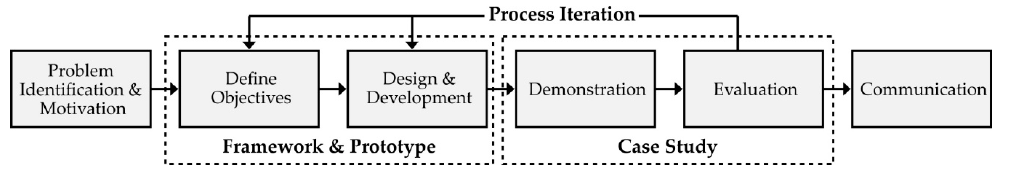
Figure 1. Overview of the research design in this study (based on the methodology described in [17]).